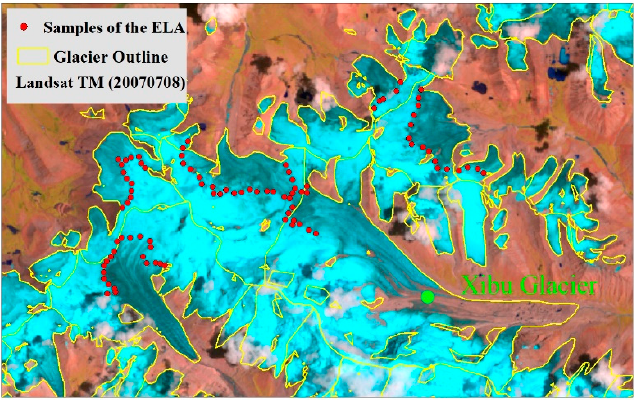
Figure 4. One example of ELA extraction in the central WNM. The base map is Landsat TM false color images of band 5, band 4 and band 2 shown in red, green and blue composition on